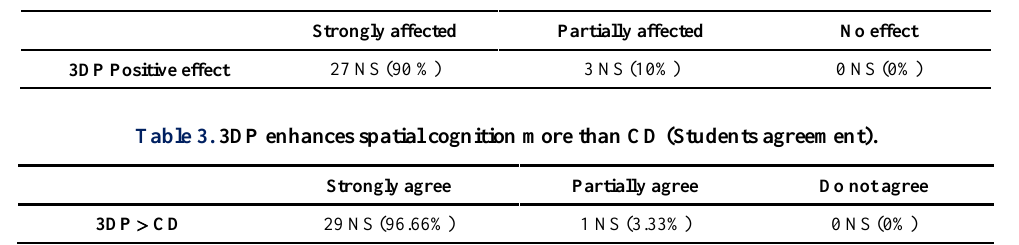
Table 2. Positive effect of 3D printed model on students’ spatial cognition.